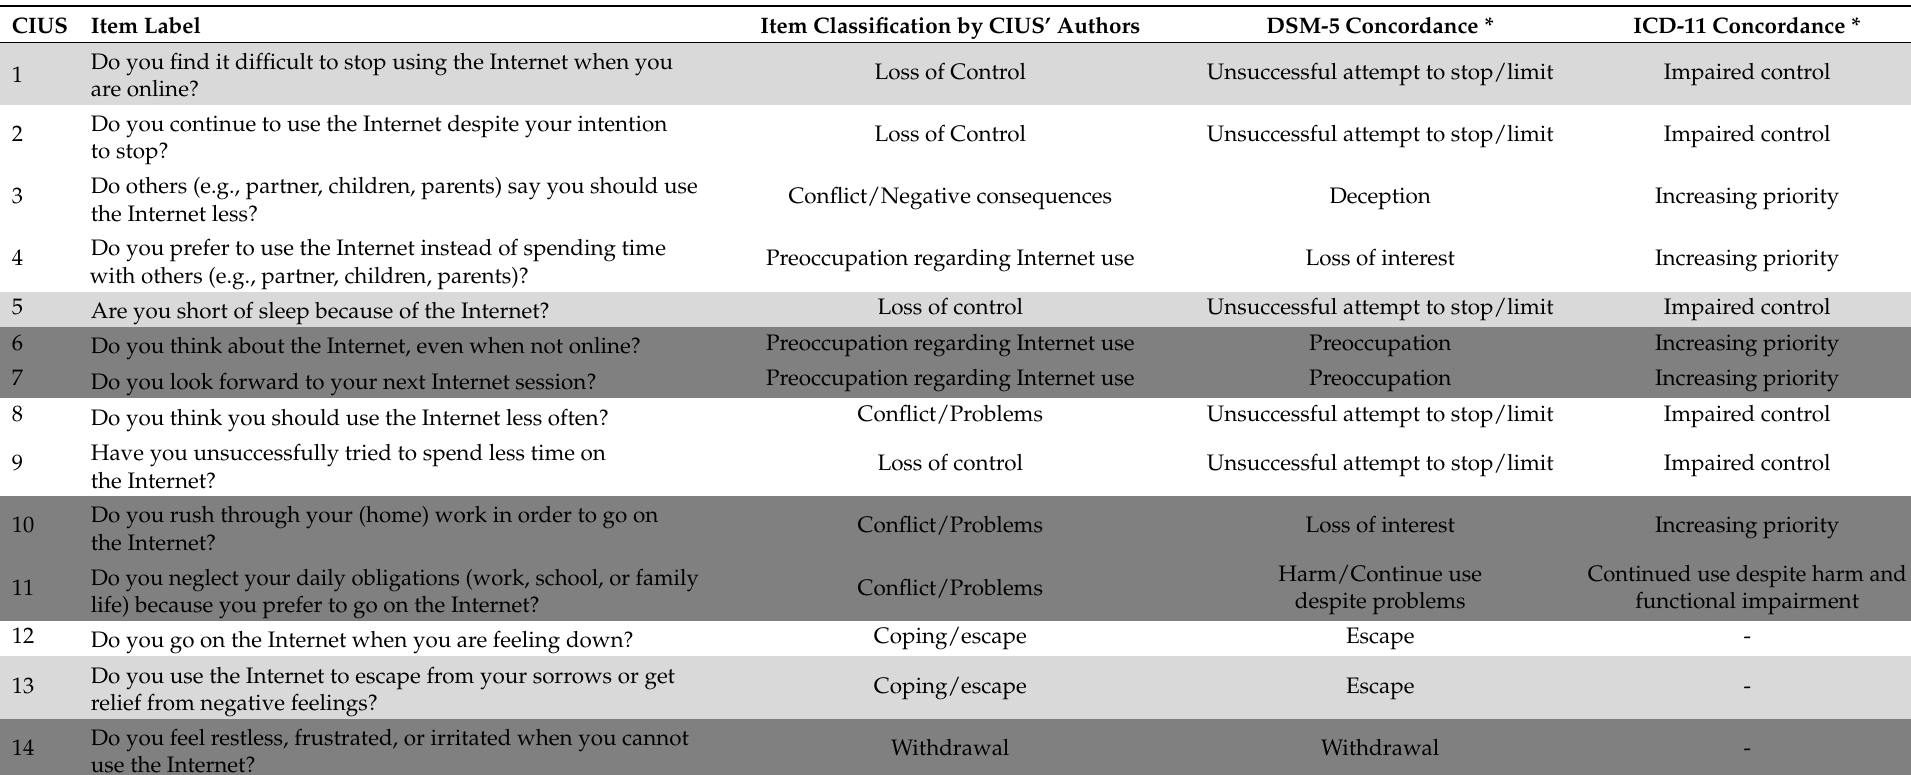
Table 5. Suggested classifications of the CIUS-14